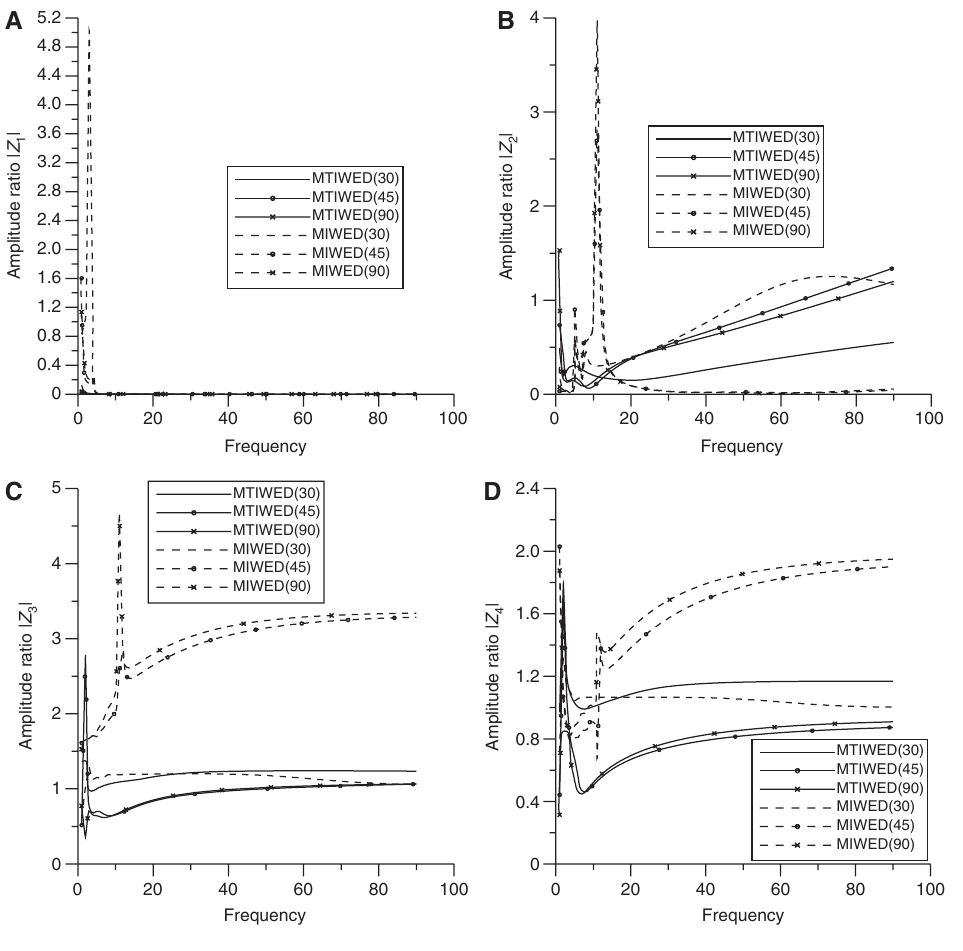
|, (B) amplitude ratio | Z 1